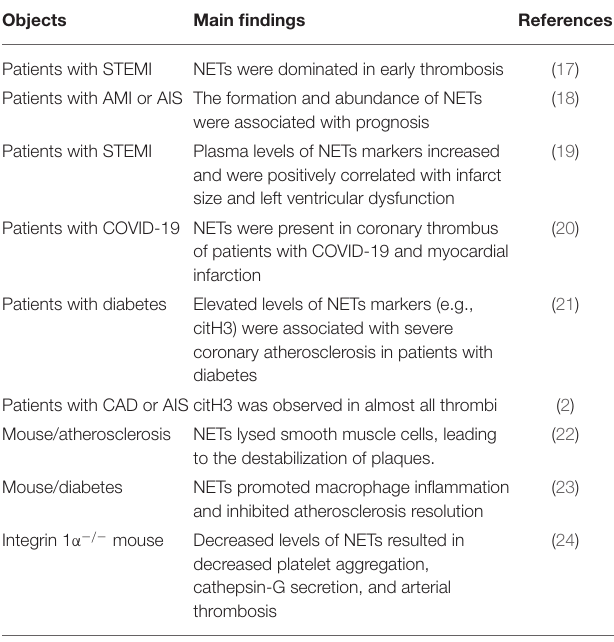
TABLE 1 | NETs in atherosclerosis and arterial